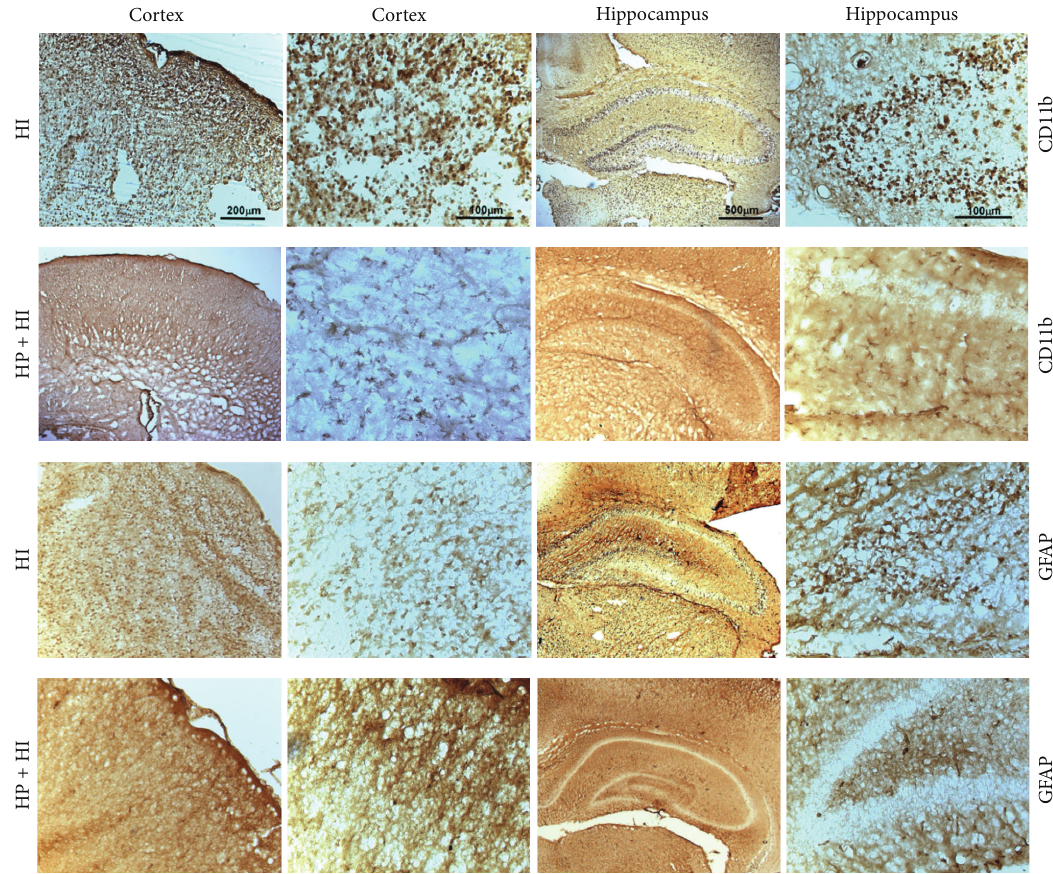
Figure 2: Hypoxia preconditioning inhibits microglial and astroglial activation in neonatal hypoxia-ischemia brain injury. Hypoxia- ischemia (HI) significantly induced microglial (first panel, CD11b) and astroglial activation (third panel, GFAP) in the cerebral cortex and hippocampus, which was correlated with neuronal damage (as shown in Figure 1). Hypoxia preconditioning (HP + HI) diminished the activationofmicroglial(secondpanel,CD11b)andastroglialcells(fourthpanel,GFAP)afterhypoxia-ischemiainjury.Basedonmorphological observations, most microglial cells in the representative section were in an activated state in HI group, but a ramified form (resting state) in the HP + HI